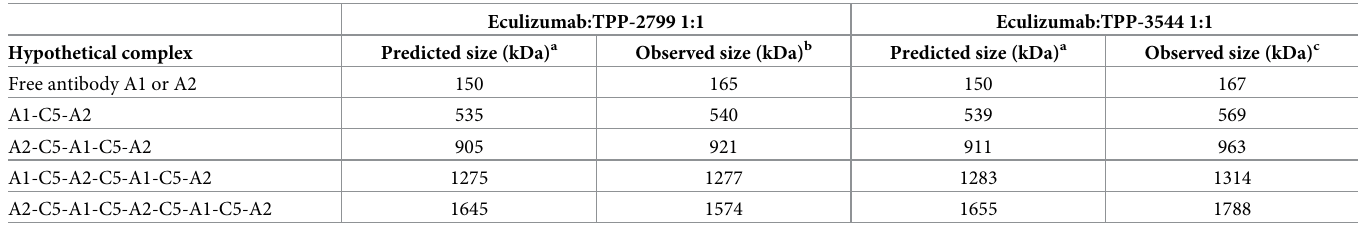
a Predicted sizes calculated using an observed free C5 MALS mass of 205 kDa (S1C Fig) together with observed sizes for monovalent free antibody of 165 kDa for composition with TPP-2799 and 167 kDa for compositions with TPP-3544. b Masses taken from Fig 3C. c Masses taken from Fig